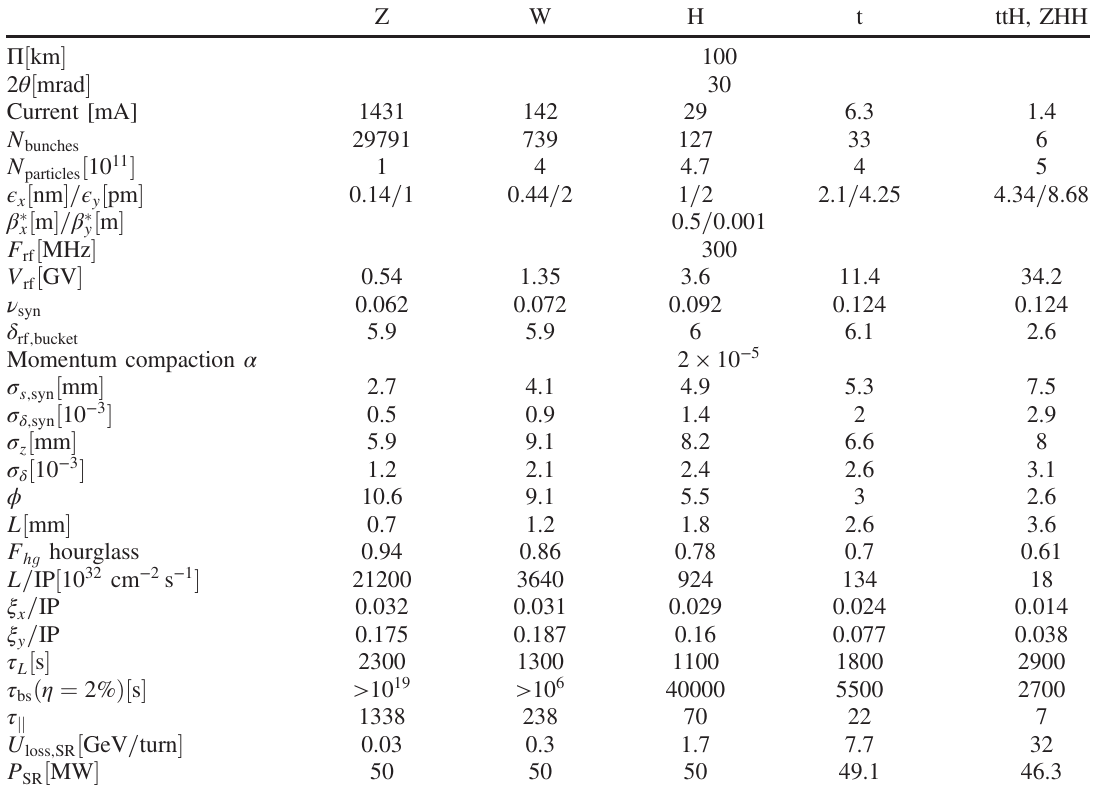
TABLE II. A new set of parameters with crossing angle and crab waist. Z W